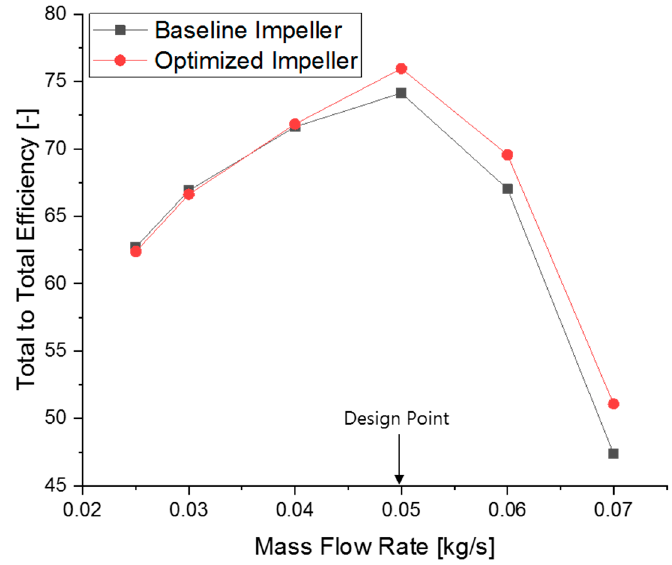
Figure 12. Total-to-total efficiency comparison between the optimal and baseline impellers.